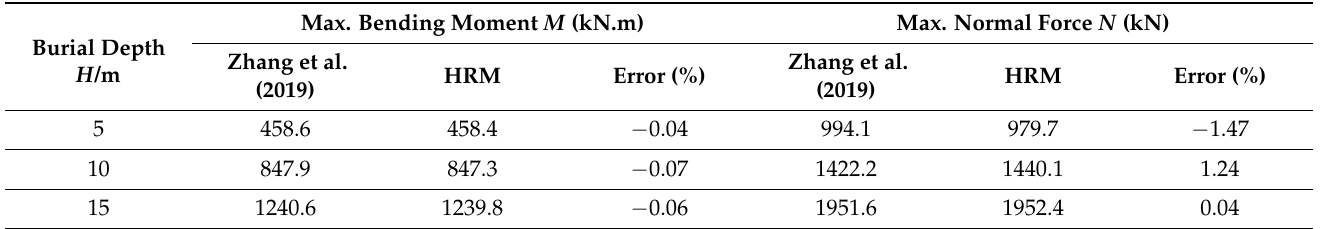
Table 1. Comparison of the HRM and results of Zhang et al. [4] with different tunnel depths H . Max. Bending Moment M (kN.m) Burial Depth H /m